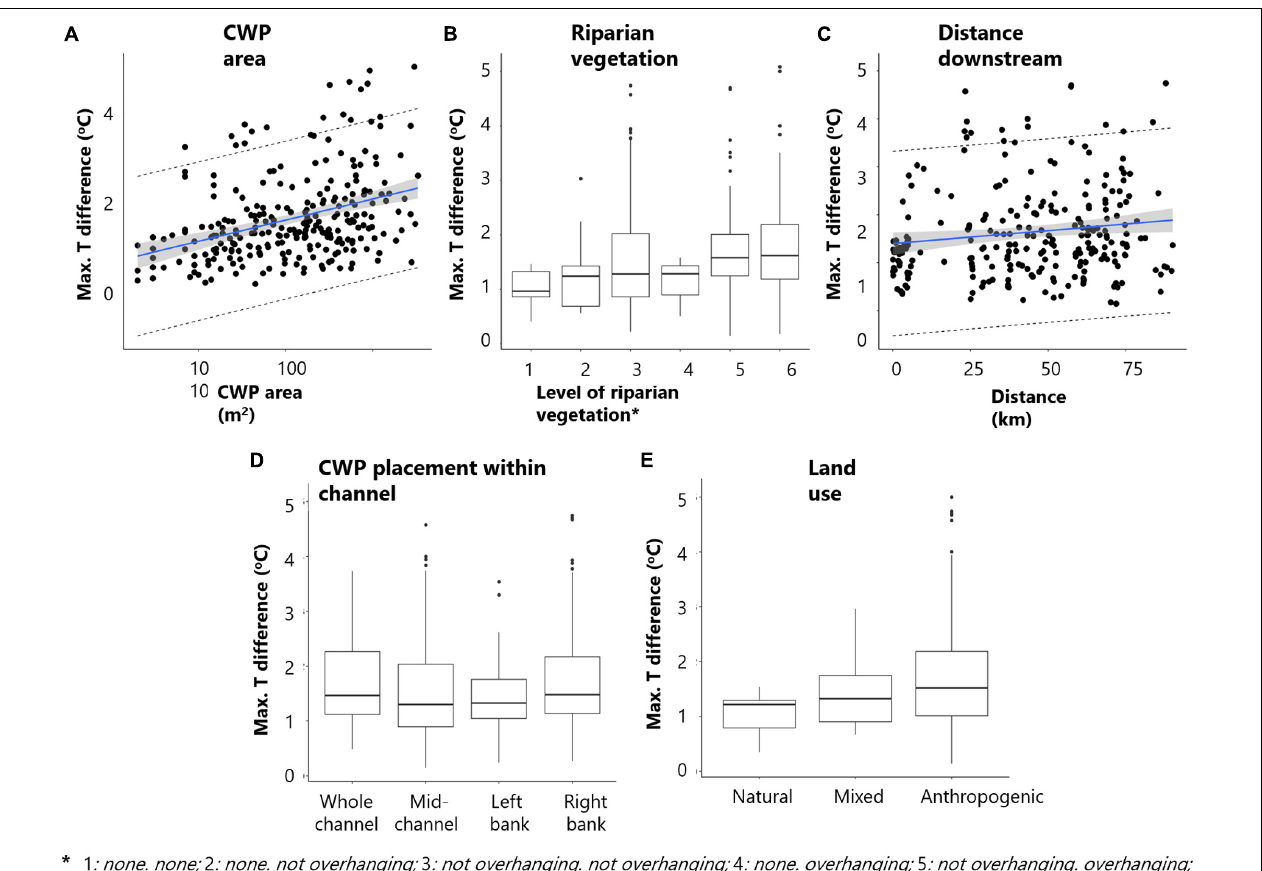
FIGURE 8 | Key variables influencing the maximum thermal difference promoted by CWPs, according to the final selected model. They include CWP area (A) , Riparian vegetation (B) , distance downstream (C) , CWP placement within channel (D) , and land use (E) .